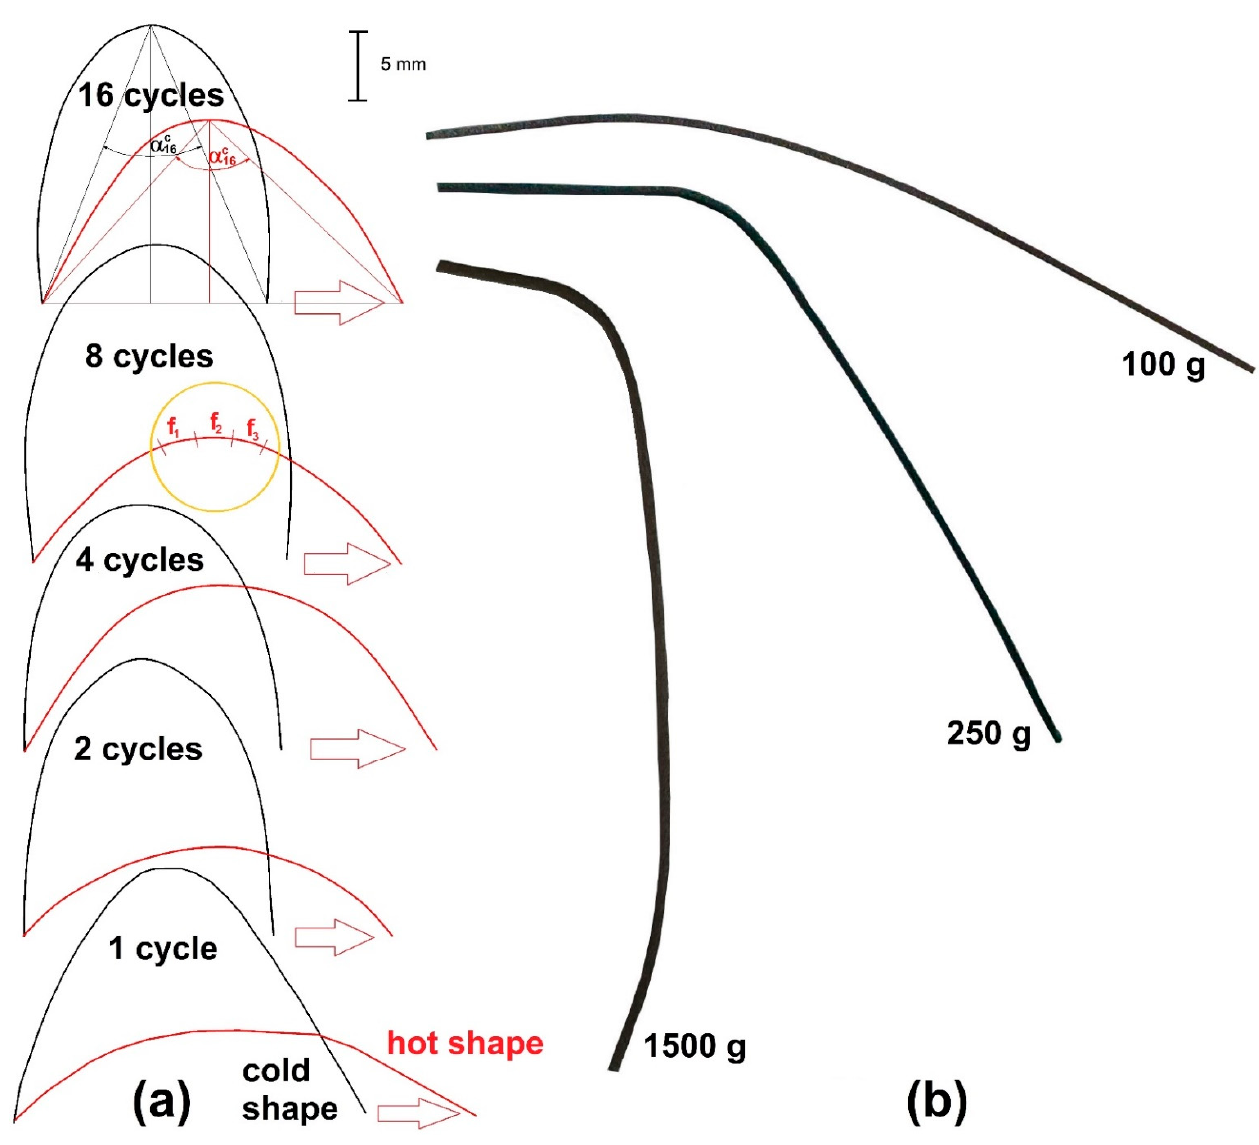
Figure 2. Evolution of specimens’ profiles during experimental training procedures based on: ( a ) FR-SME during 16 cycles; ( b ) WG-SME under applied loads, increasing up to 1500 g. SME during 16 cycles; ( b ) WG-SME under applied loads, increasing up to 1500